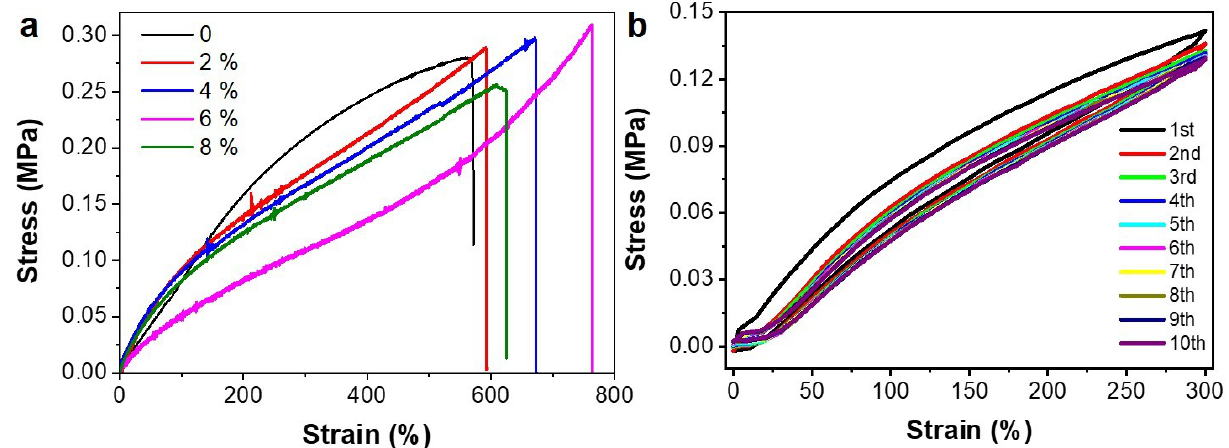
Figure 4. ( a ) The tensile stress-strain curves of the PAA/FF/KCl gels with different KCl (wt%). ( b ) The cyclic tensile stress-strain curves of the PAA/FF/KCl gel with 6 wt%